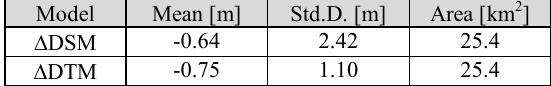
Table 3. Statistics of height differences between LiDAR and